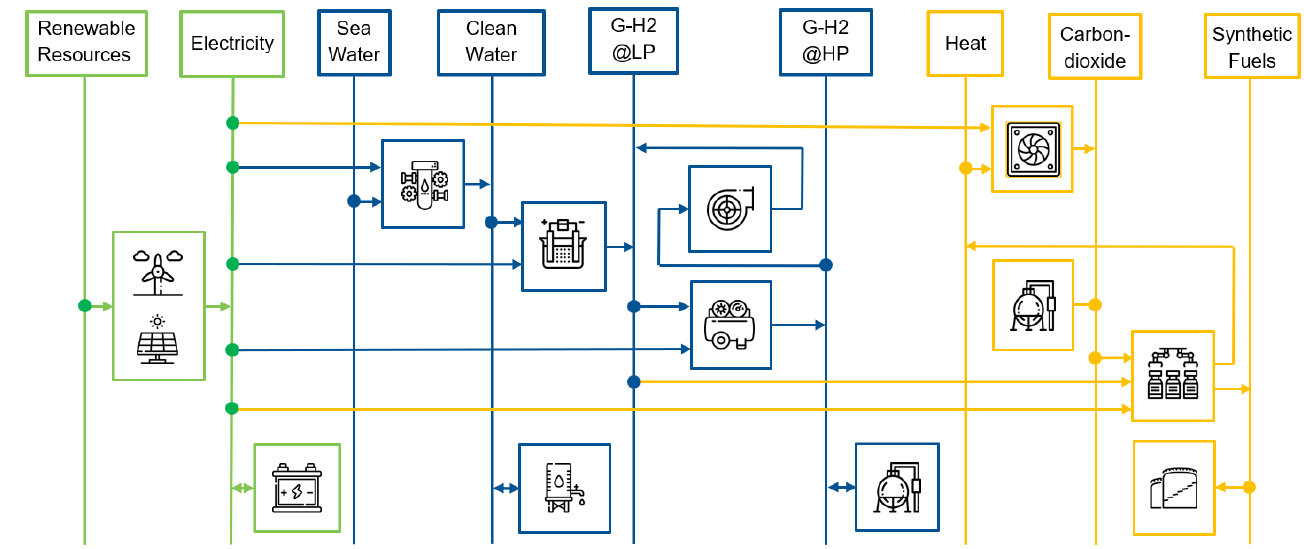
Figure 1. Reference Energy System (RES) (icons by flaticon.com (accessed on 30 January 2023)). The first and second parts of the model correspond to green hydrogen